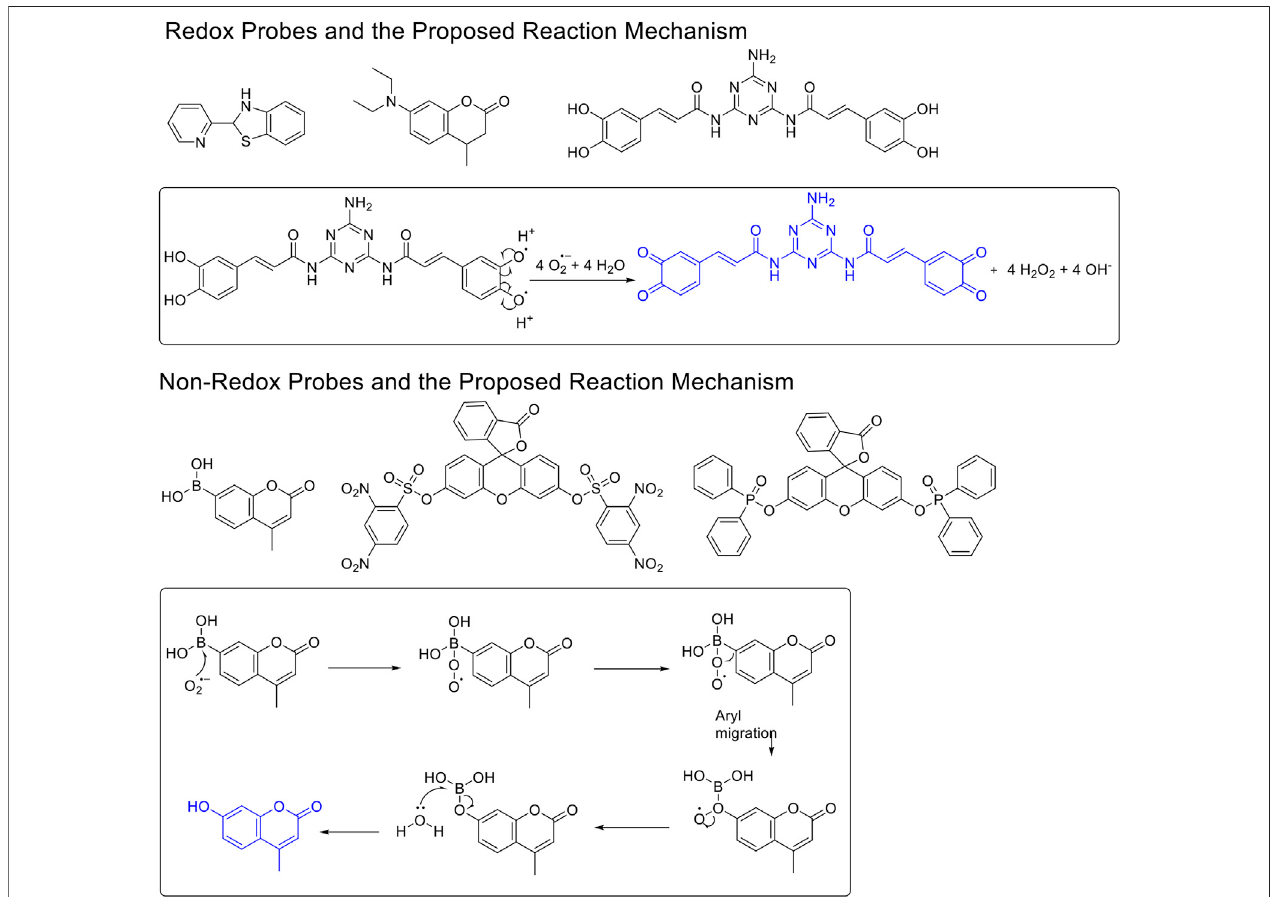
FIGURE 1 | The redox- and non – redox-based superoxide anion probes. The reaction mechanisms of the selected probes were also proposed to help to understand this study.